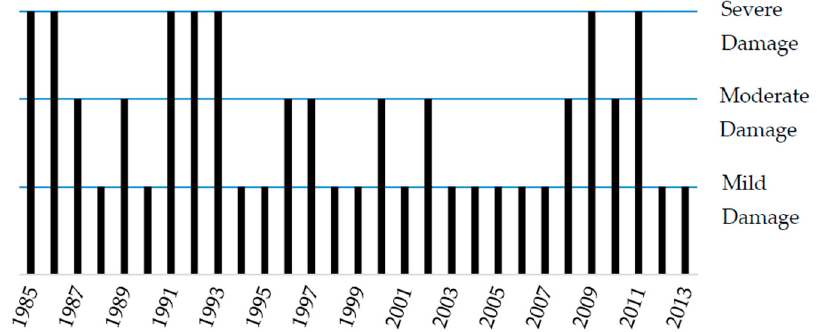
Figure 6. Degrees of damage of the caterpillar from the year 1985 to 2013.